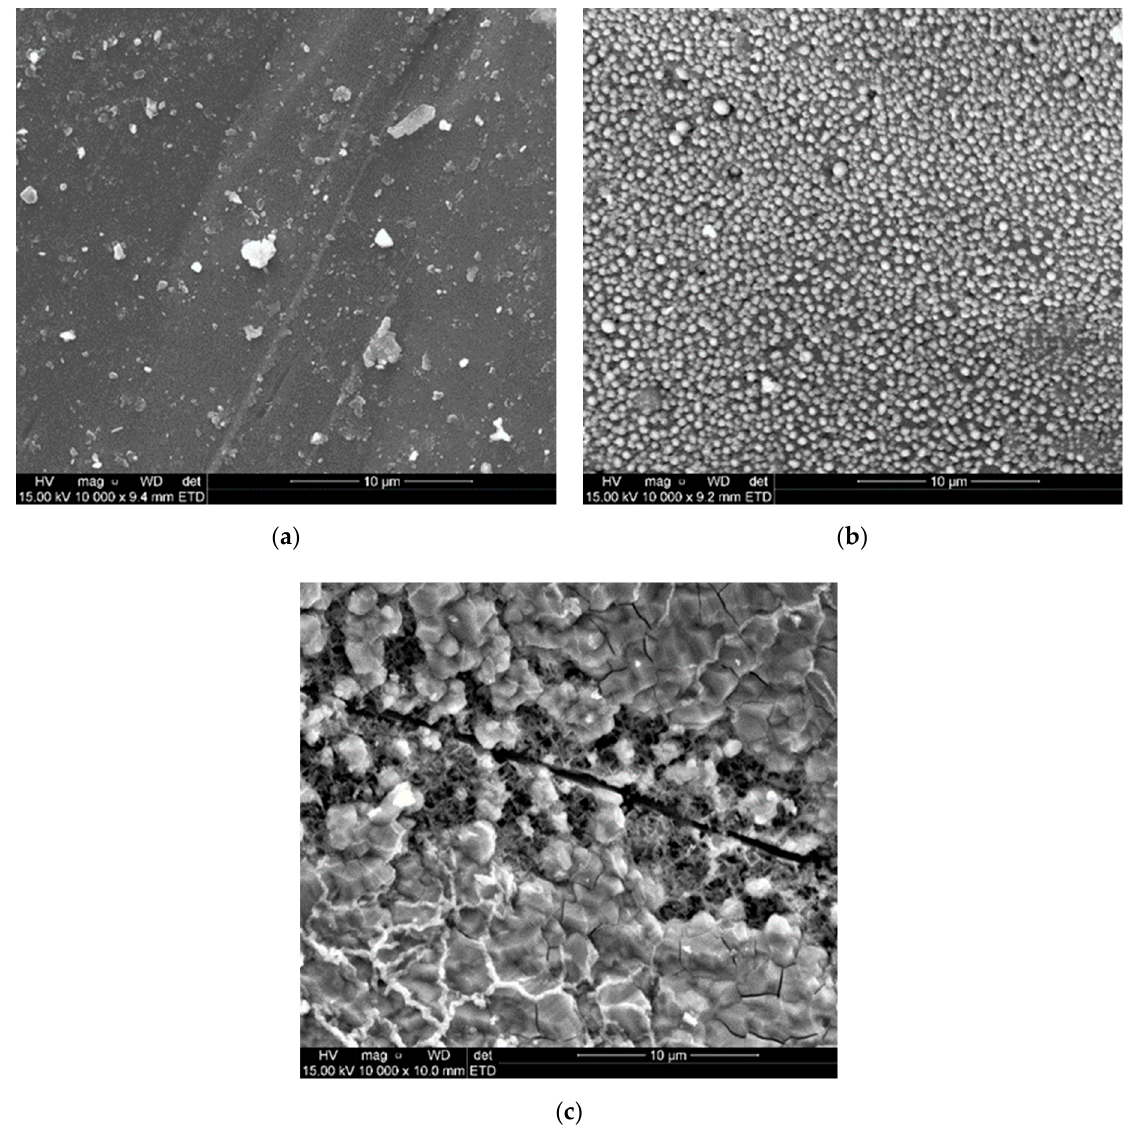
Figure 4. Secondary electron SEM micrographs of the surface of as-received chromite particles ( a ) reduced at a 150 mL/min ( b ) and 750 mL/min ( c ) hydrogen flow rate. Samples were reduced at 1100 °C for 60 min.